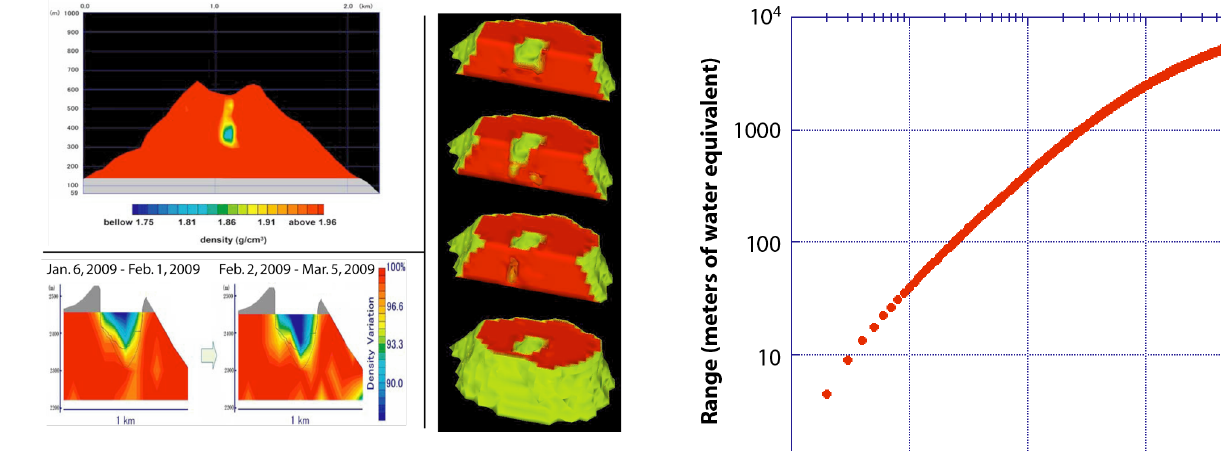
Fig. 1. Multiple examples of the resolving power of muon radiog- Figure 1: Multiple examples of the resolving power of muon radiography. Top left: Density 5 raphy. Top left: density profile of a terrestrial volcano obtained with profile of a terrestrial volcano obtained with secondary cosmic ray muons [ Tanaka et al , 2009a]. 6 secondary cosmic ray muons (Tanaka et al., 2009a). Bottom left: Bottom left: Detected mass change inside a volcano using cosmic-ray muon radiography 7 detected mass change inside a volcano using cosmic-ray muon ra- [Tanaka et al., 2009b]. Right: Vertical slices showing a 3D profile of the interior of Mt. Asama 8 diography (Tanaka et al., 2009b). Right: vertical slices showing a constructed by Tanaka et al . [2010] using data from a muon radiography survey at multiple 9 3-D profile of the interior of Mt. Asama constructed by Tanaka et locations around the dome. 10 al. (2010) using data from a muon radiography survey at multiple locations around the dome.